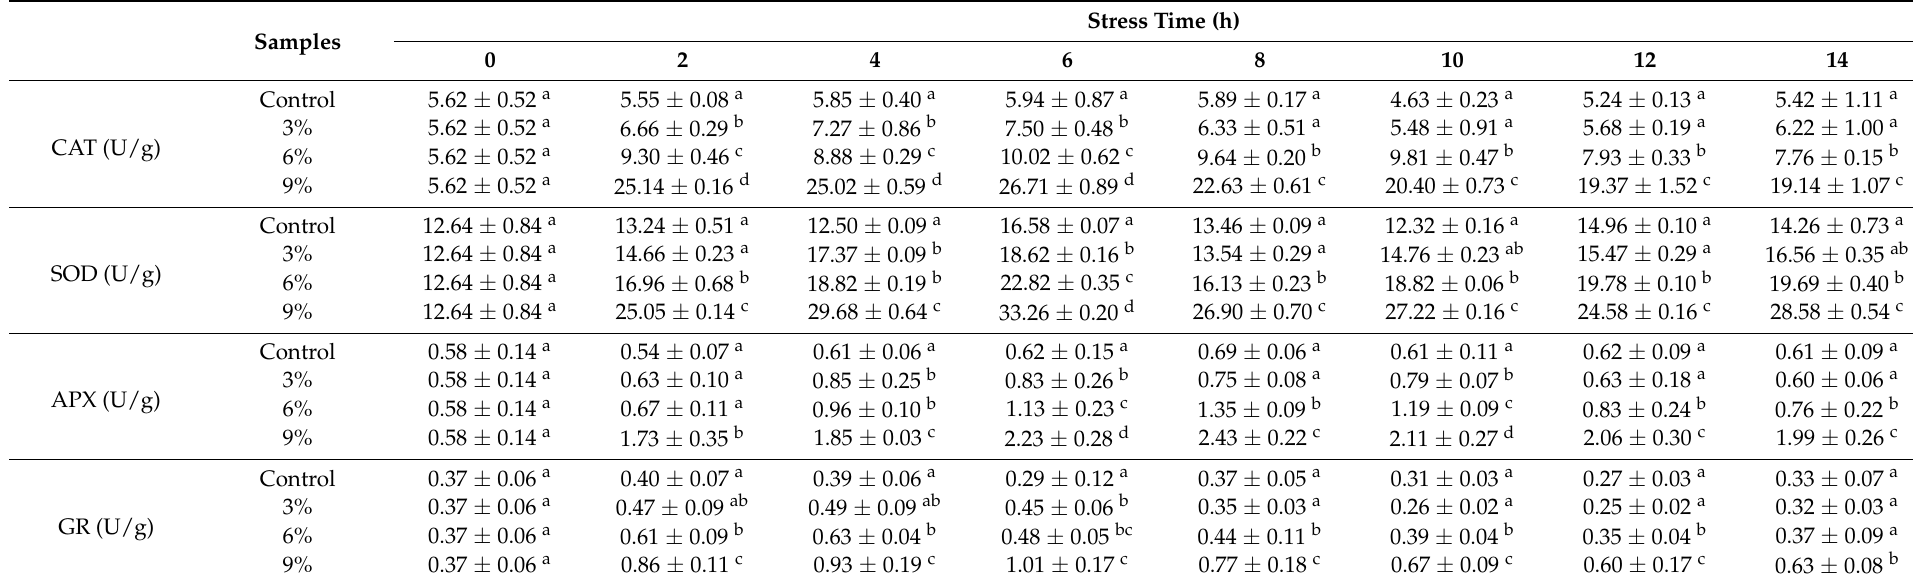
Table 2. Effects of different concentration of ethanol stress on the antioxidant enzymes activity of P. anomala NCU003.